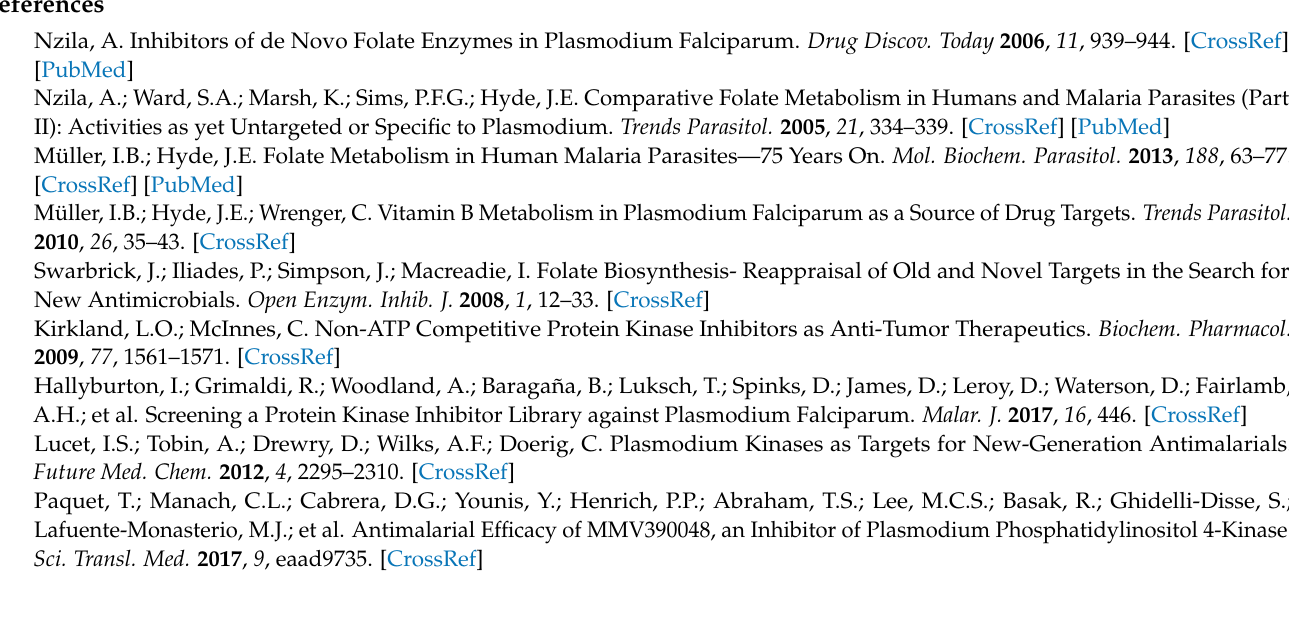
Figure S2: Protein sequencing result for Pf HPPK-GFP; Figure S3: GFP melting temperature in the presence of various concentrations of A.T.P.; Figure S4: D.S.F. curves obtained for HPPK-GFP and GFP proteins; Table S1. Molecular docking scores obtained from antifolate library virtual screening; Figure S5: Dose-response inhibition for compound 14; Figure S6. Superimposition of Pf HPPK structures in the apo form and HMDP-bound